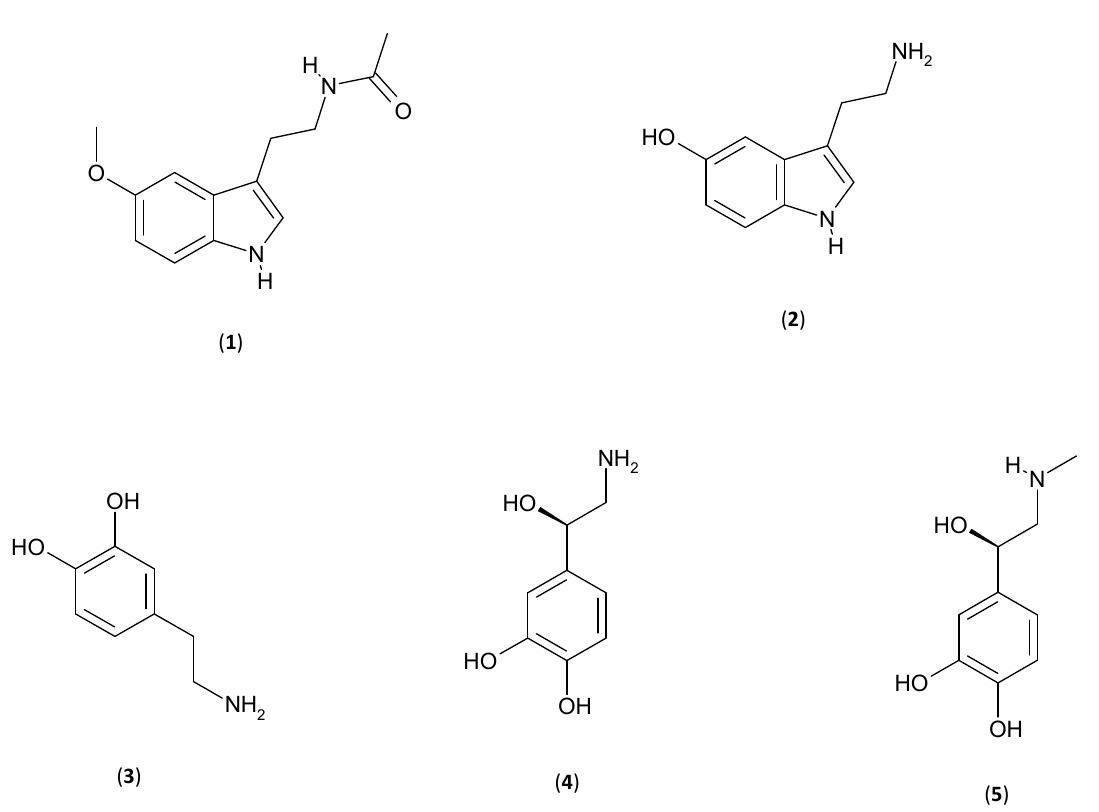
mammalian neurotransmitters and neurohormones indoleamines (melatonin and serotonin) and catecholamines (dopamine, norepinephrine and epinephrine) (Figure 1). Figure 1. Chemical structures of the indoleamines ( 1 ) melatonin ( N -acetyl-5- methoxytryptamine) and ( 2 ) serotonin (5-hydroxytryptamine), and the catecholamines ( 3 ) dopamine (3-hydroxytyramine), ( 4 ) norepinephrine (or noradrenaline) and ( 5 ) epinephrine (or